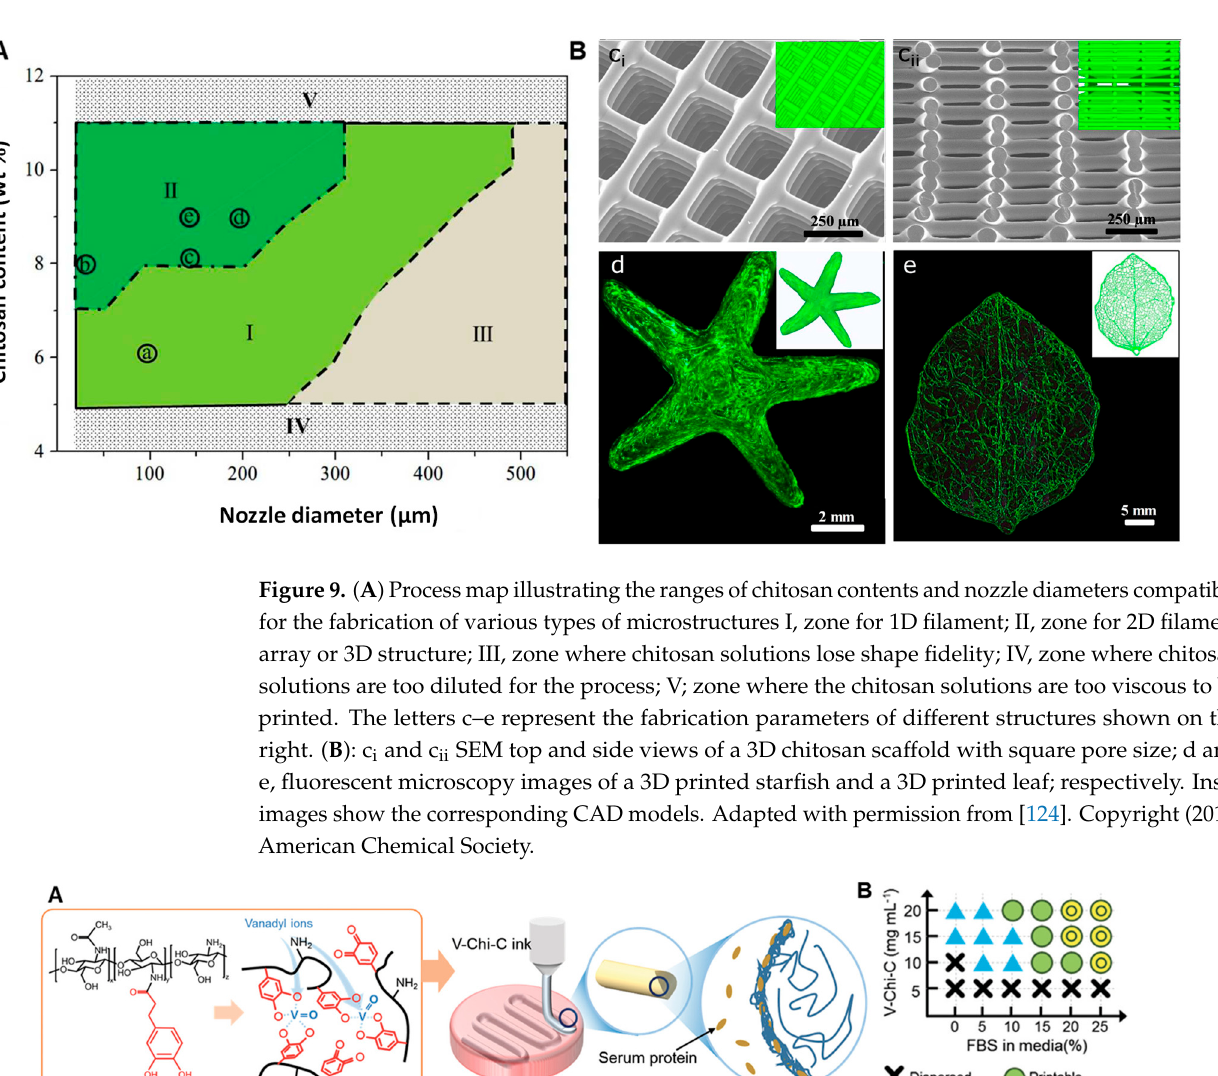
Figure 9. ( A ) Process map illustrating the ranges of chitosan contents and nozzle diameters compat- ible for the fabrication of various types of microstructures I, zone for 1D filament; II, zone for 2D filament array or 3D structure; III, zone where chitosan solutions lose shape fidelity; IV, zone where chitosan solutions are too diluted for the process; V; zone where the chitosan solutions are too vis- cous to be printed. The letters c–e represent the fabrication parameters of different structures shown on the right. ( B ): c i and c ii SEM top and side views of a 3D chitosan scaffold with square pore size; d and e, fluorescent microscopy images of a 3D printed starfish and a 3D printed leaf; respectively. Inset images show the corresponding CAD models. Adapted with permission from [124]. Copyright (2018) American Chemical Society.